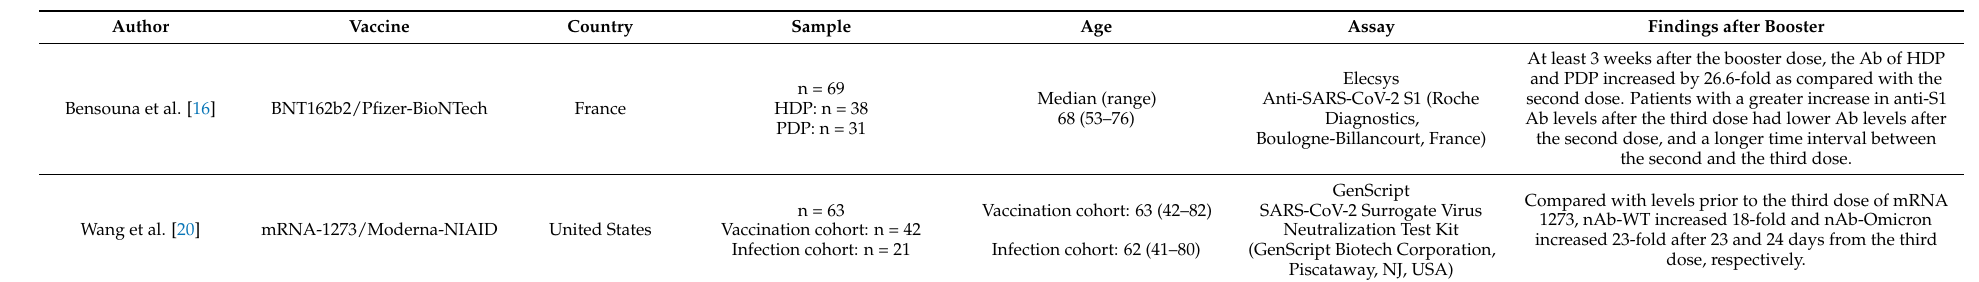
Table 3. Studies investigating the humoral response of hemodialysis patients post-COVID-19 vaccination with